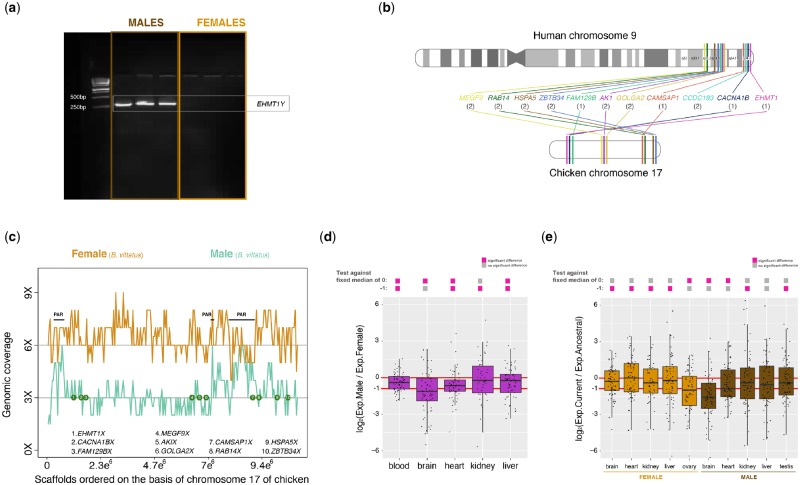
—Analysis of the novel XY chromosomes. (a) Agarose gel showing the PCR products of the EHMT1Y and COL1A1 genes. The control gene, COL1A1, was amplified in both males and females, whereas the exemplified Y-specific gene, EHMT1Y, was amplified only in males. (b) Diagram depicting the chromosomal positions in human and in the chicken of the orthologous genes to the XY gametologues in Basiliscus vittatus. The numbers correspond to the strata assignments (see Table 1 and main text). (c) Coverage results for the novel X chromosome in B. vittatus using either male (green line) or female (orange line) genomic reads. The X chromosome in B. vittatus was assembled on the basis of the chicken chromosome 17. Green circles denote the approximate location of the X gametologues; numbers correspond to the genes shown in the figure. (d) Boxplots representing the male/female expression ratios of genes located on the novel X chromosome (n = 67 genes) in somatic tissues. Significant differences (Mann–Whitney U test): Benjamin–Hochberg-corrected P < 0.05 of temperatures against distributions with fixed medians of 0 (i.e., similar expression levels of X genes in males and females) and −1 (i.e., half the expression levels of X genes in males compared with females. (e) Boxplots representing the current/ancestral expression ratio for genes located on the novel X chromosome (n = 67 genes) for female tissues (light brown) and male tissues (dark brown). Significant differences (Mann–Whitney U test): Benjamin–Hochberg-corrected P < 0.05 of temperatures against distributions with fixed medians of 0 (i.e., current and ancestral expression levels are similar) and −1 (i.e., current expression levels are half of the ancestral expression levels). (d–e) Gray filled squares denote nonsignificant differences between male/female ratios of X genes and a distribution with fixed medians (0 or −1), whereas pink filled squares denote significant differences. Depending on the dispersion of the data, a sample could be either not significant or significantly different from the two fixed medians. Error bars, maximum and minimum values, excluding outliers.